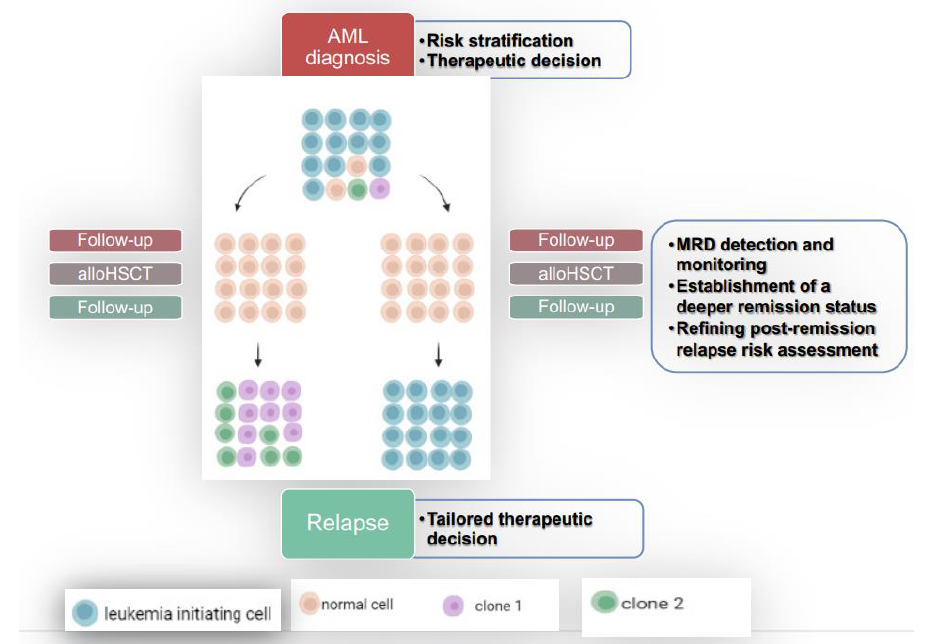
Figure 4. Role of single-cell sequencing from diagnosis to relapse. MRD monitoring (by MFC, RQ-PCR, and NGS) and the assessment of clonal evolu- tion (by NGS) from diagnosis to transplant should be made mandatory as soon as possible in order to more accurately identify patients who need to be submitted early for transplant and those who are candidates for pre-emptive or maintenance therapy after transplant. This approach required a continuous collaboration between AML teams (with the cell team), laboratory teams, and transplant teams from diagnosis to post-transplant follow- up (Figure 5).